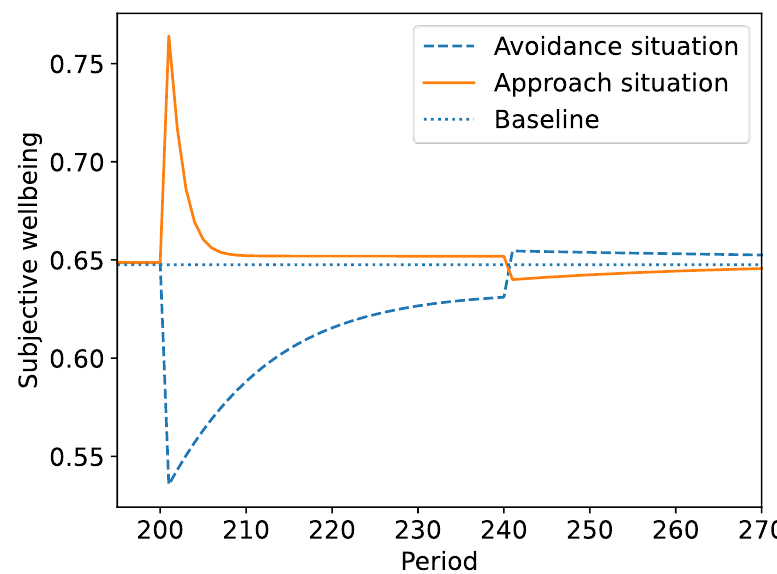
Figure 5. Hedonic adaptation of one individual to a 20-fold increase in the frequency of an approach cue (highest line) or an avoidance cue (lower line) for a duration of 40 periods.